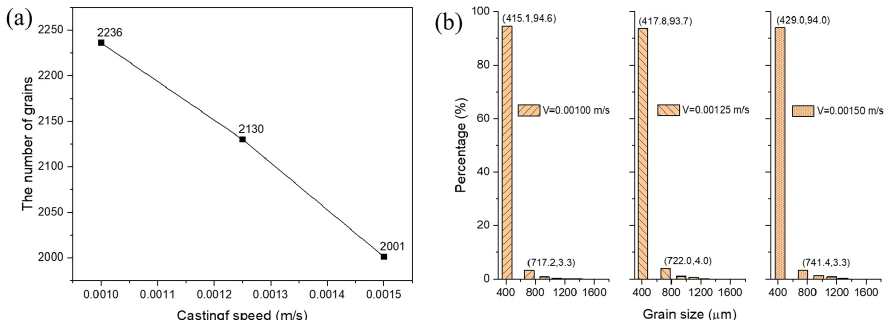
Figure 14. The number of grains and the grain size distribution on the cross-section of the billet with different casting speeds, where ( a ) is the variations of total grains numbers, and ( b ) is the percentage of grains of different sizes.